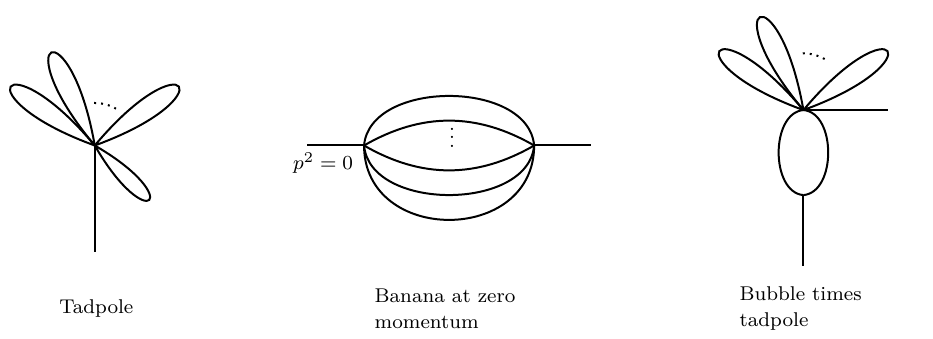
Figure 2 . Sub-topologies of the ice cone graph with corresponding master integrals I 0 , 0 (left), I 0 , 1 , , . . . , I (middle) and I 0 0 , b l/ 2 c